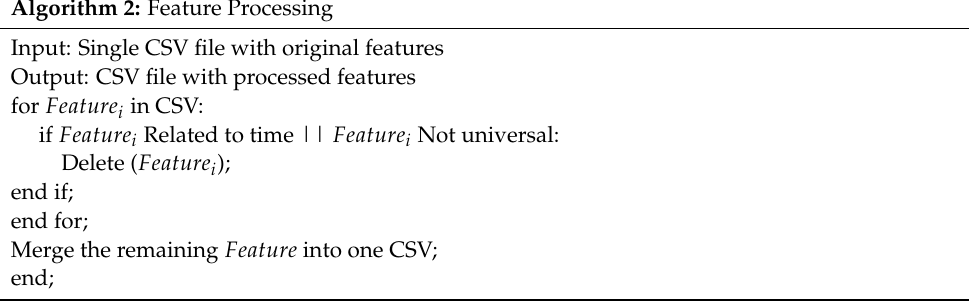
Algorithm 2: Feature